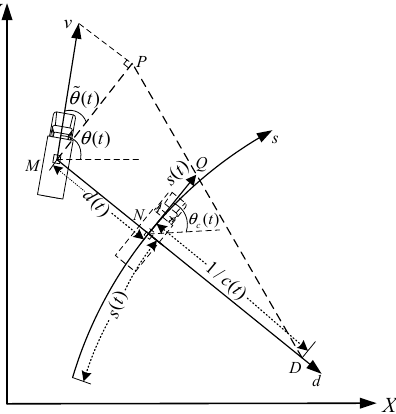
Figure 2. Coordinate system conversion diagram.